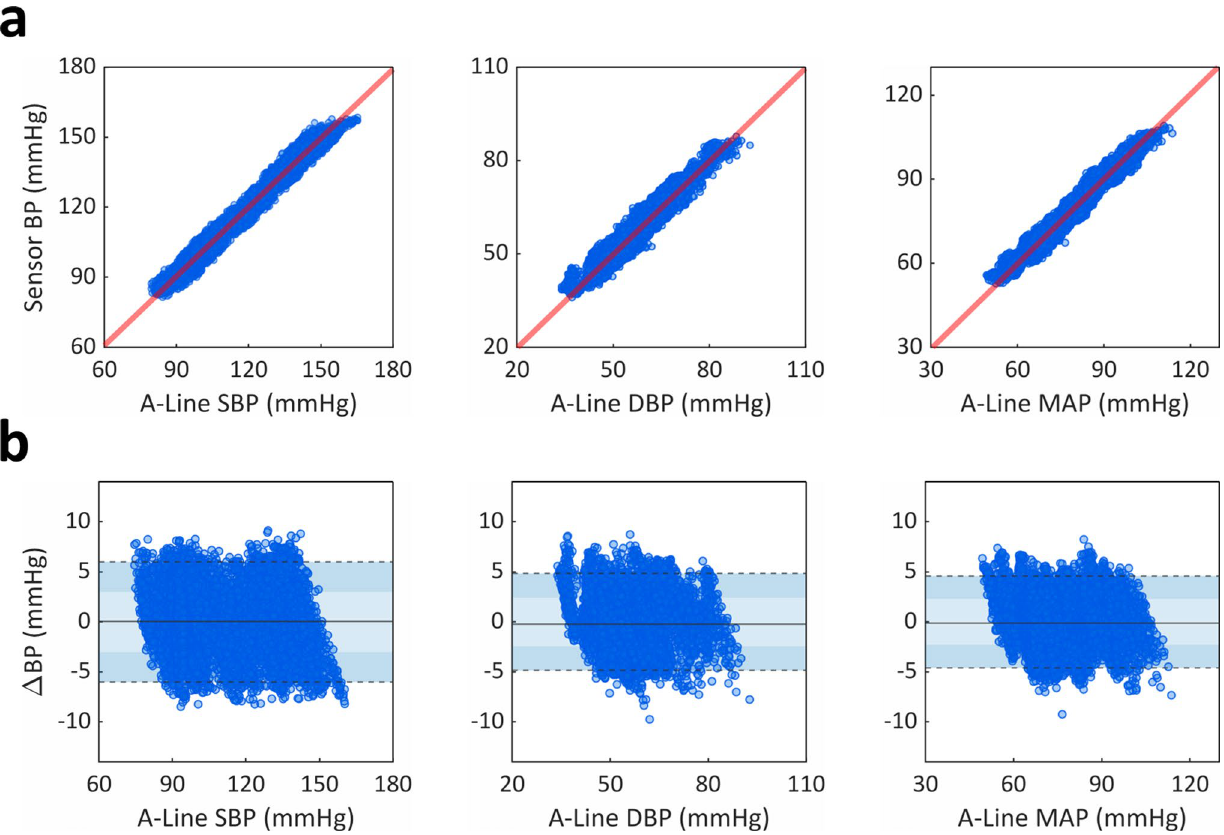
Figure 3. Assessing accuracy and precision of inpatient BP monitoring using a CAP sensor. ( a ) Pearson correlation and ( b ) Bland–Altman analyses compared beat-to-beat (left) SBP, (middle) DBP, and (right) MAP measurements between the noninvasive CAP sensor and invasive A-line. ( a ) CAP sensor measurements (n = 11,002) showed strong linear correlations to the A-line, with Pearson coefficients of 0.987, 0.960, and 0.980 for SBP, DBP, and MAP, respectively. ( b ) CAP sensor measurements (n = 11,002) demonstrated mean biases of 0.05 (3.07), − 0.21 (2.47), and − 0.12 (2.35) mmHg for SBP, DBP, and MAP, respectively. Light- and dark-shaded areas represent 68% (1 SD) and 95% (1.96 SD) limits of agreement,